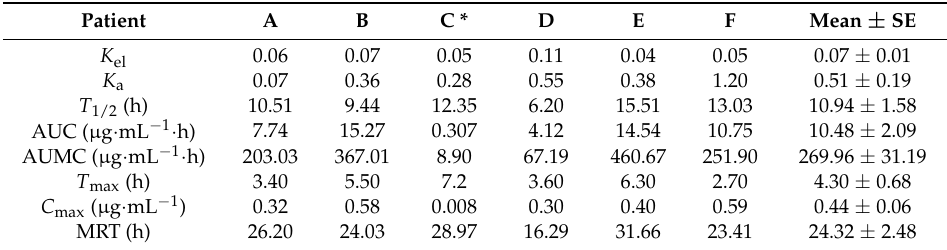
Table 2. Pharmacokinetic parameter estimates of melatonin in